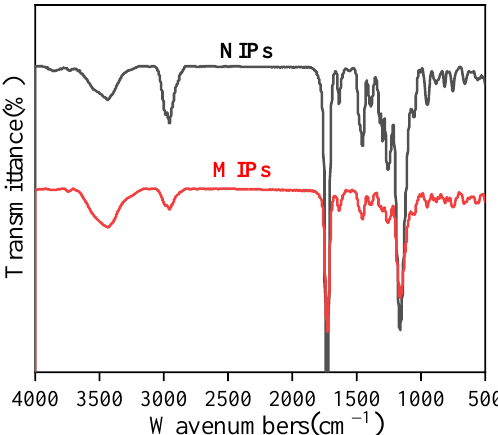
Figure 7. FT − IR spectra of the MIPs and NIPs microspheres.